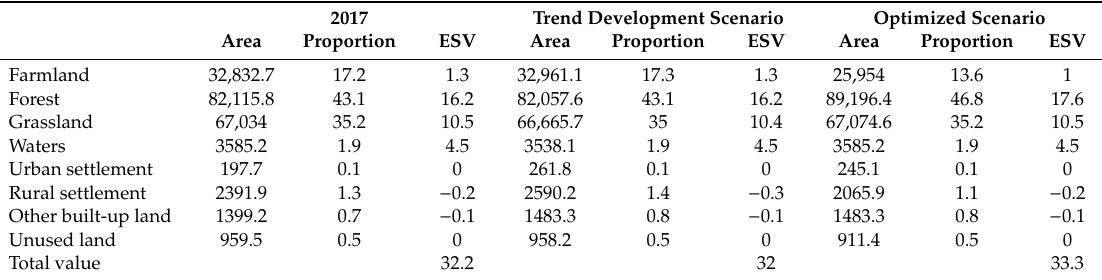
Table 5. Area of land use types under di ff erent scenarios (hm 2 , %, 10 8